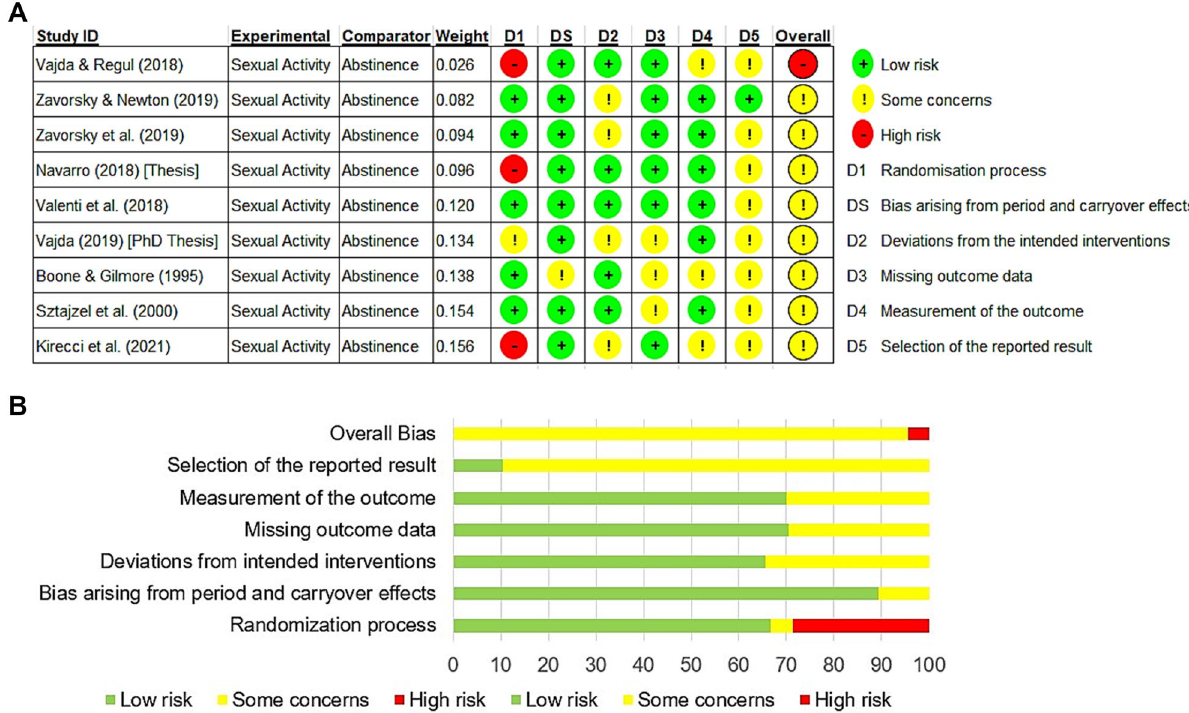
Figure 5. (A) Cochrane-style risk of bias assessment using traffic light plots displays the overall judgments by study-by-study. (B) Risk of bias graph as a percentage (per protocol). The six domains of bias, including overall bias, are